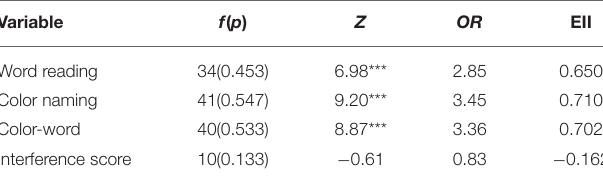
TABLE 7 | Caseness in the Stroop tasks among